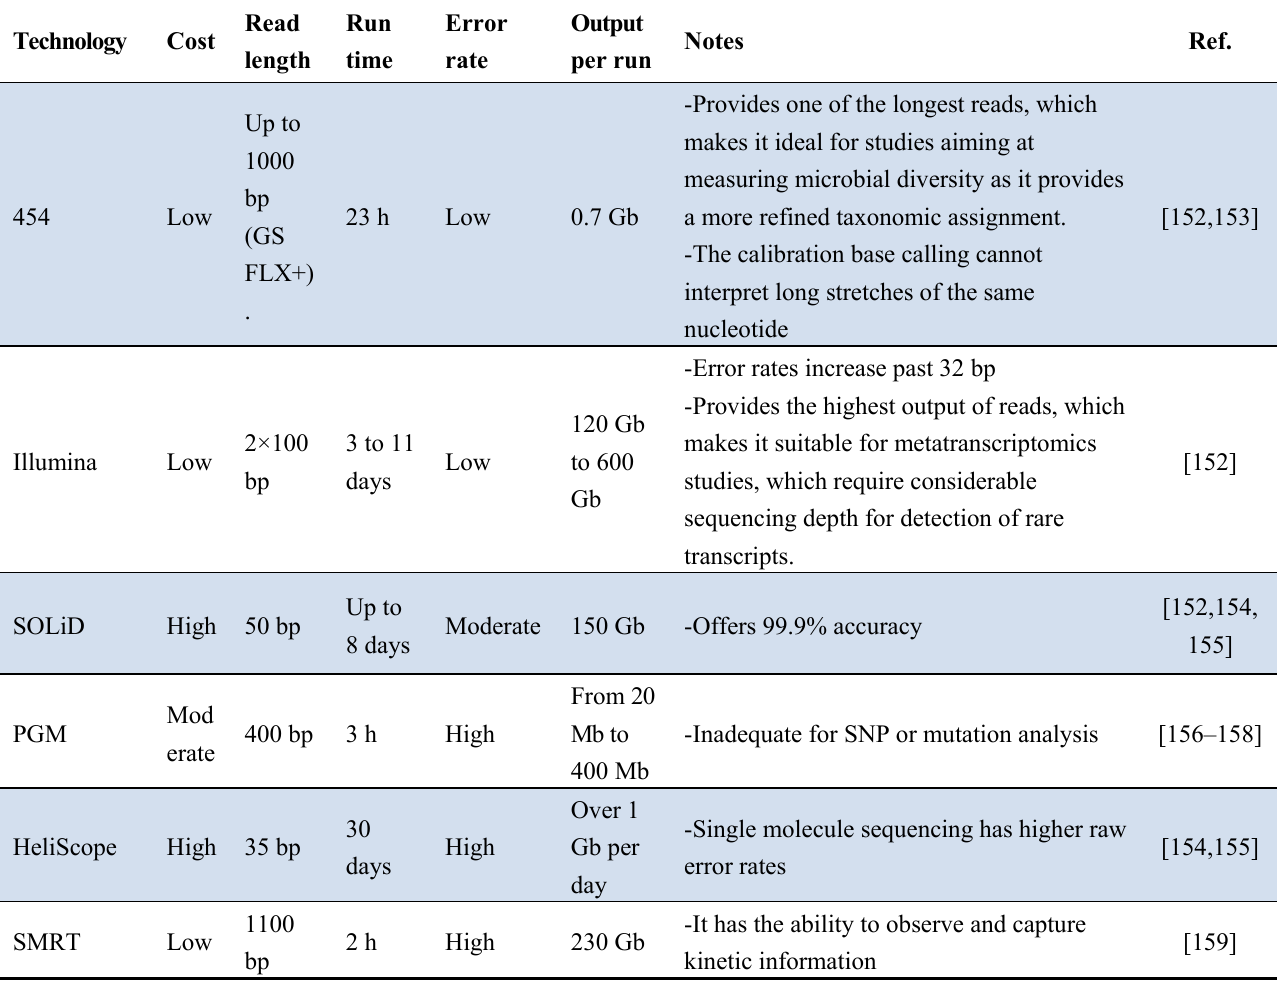
Table 2. Comparative summary of high-throughput sequencing